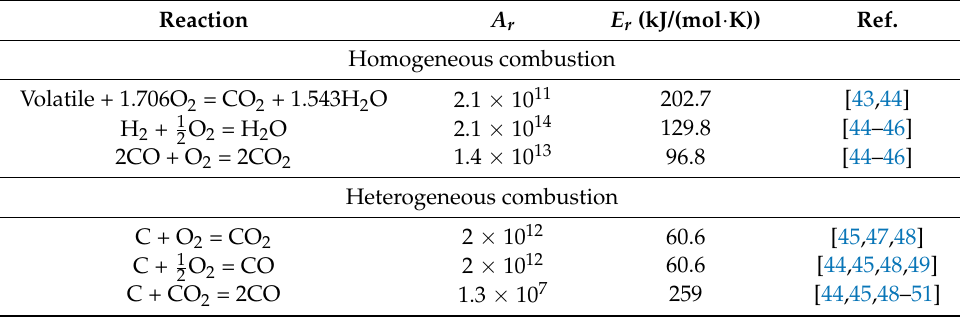
Table 6. Kinetic parameters of chemical